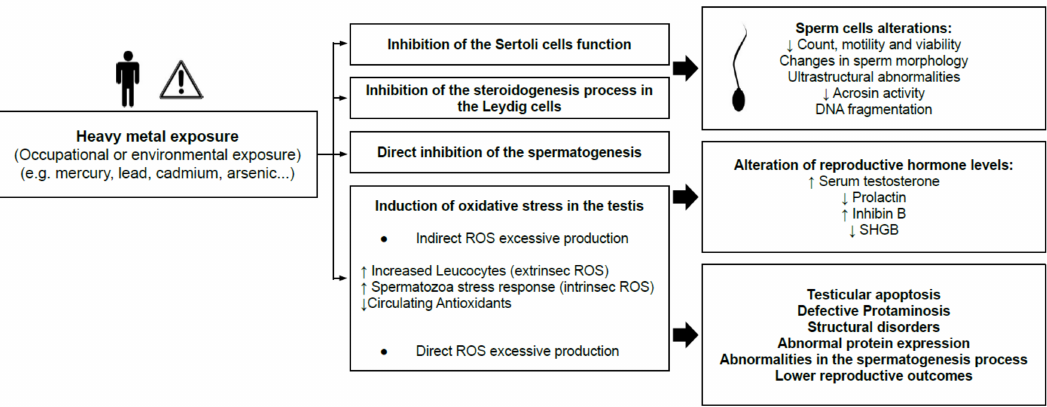
Figure 3. Summary of the effects of heavy metal exposure on men’s reproductive health. ROS, reactive oxygen species; SHBG, Sex Hormone Binding